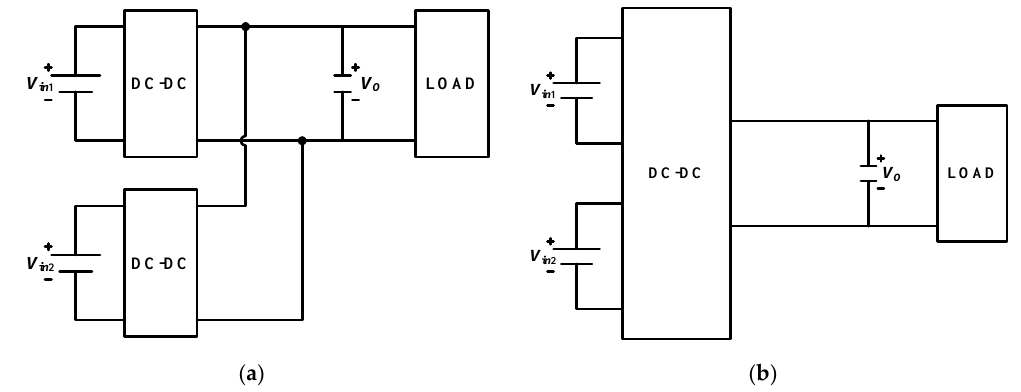
Figure 1. Conceptual diagrams of the ( a ) Distributed DC-DC converters; ( b ) Multi-input DC-DC